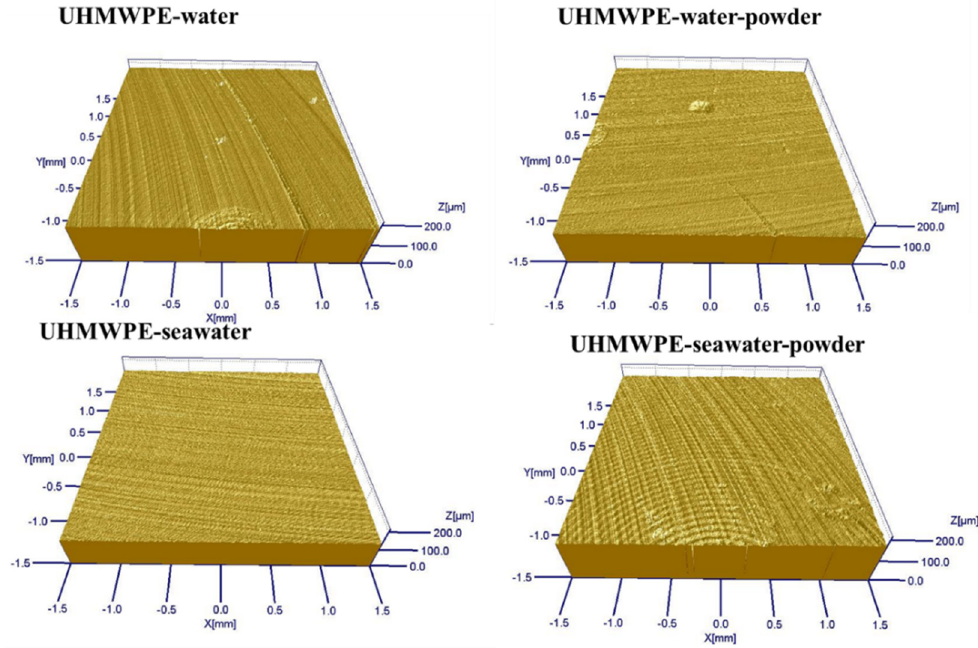
Table 4. The roughness of the UHMWPE pin surface.